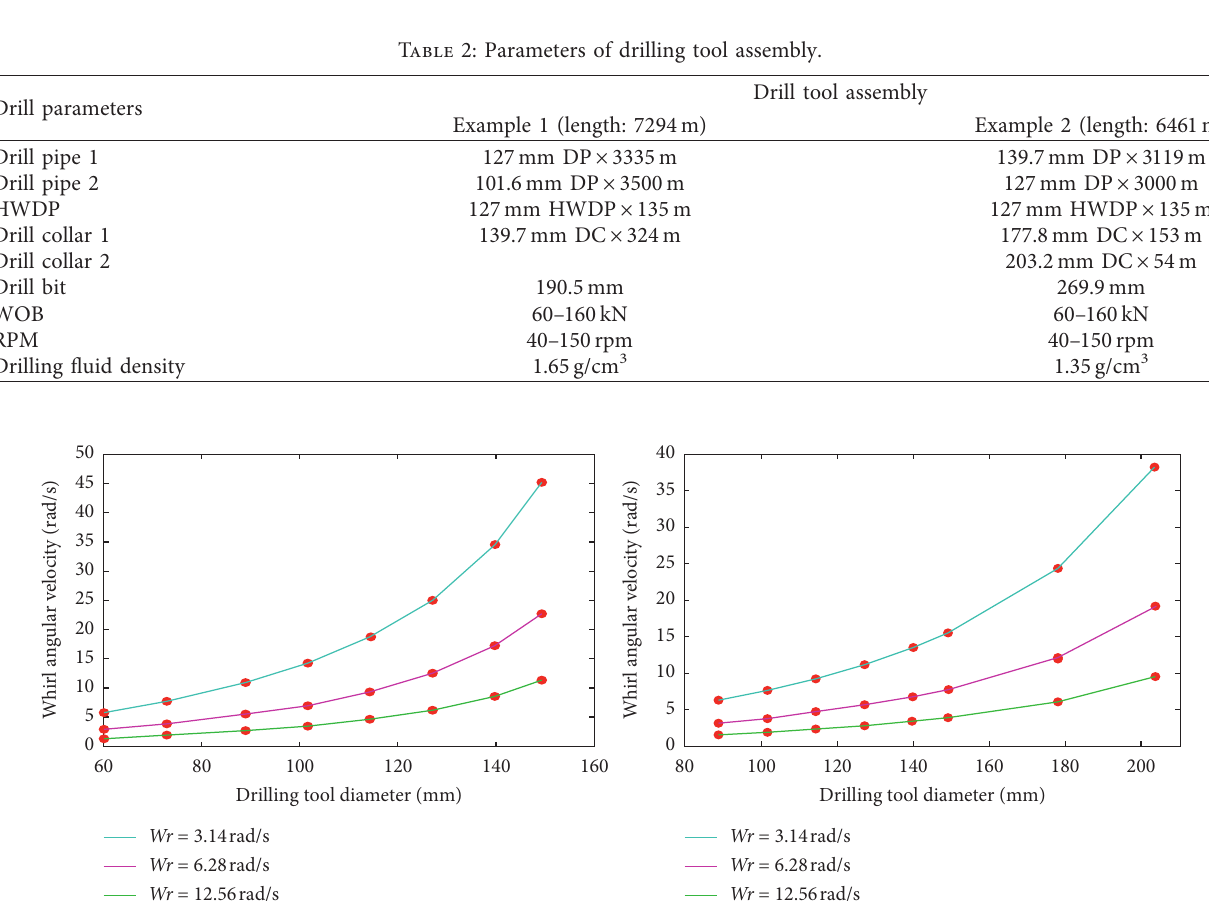
Figure 3: Angular velocity of backward whirling changes with drilling tool diameter (RPM � 30, 60, and 120 rpm).